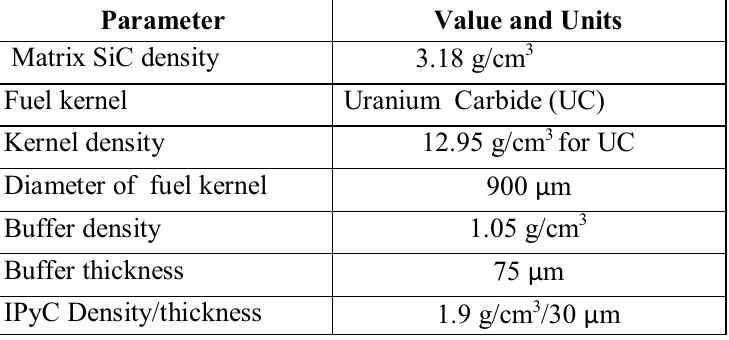
Table I. TRISO particle